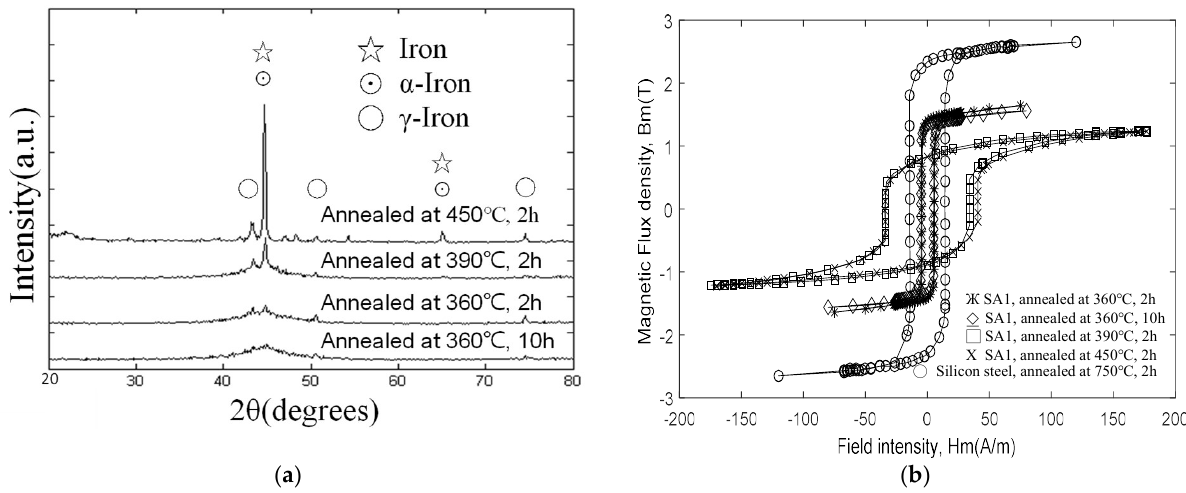
Figure 4. X-ray diffraction measurement results: ( a ) Sample SA1 crystallization peak at different temperatures and ( b ) Sample SA1 to crystallization peak and α-Fe at different temperatures.